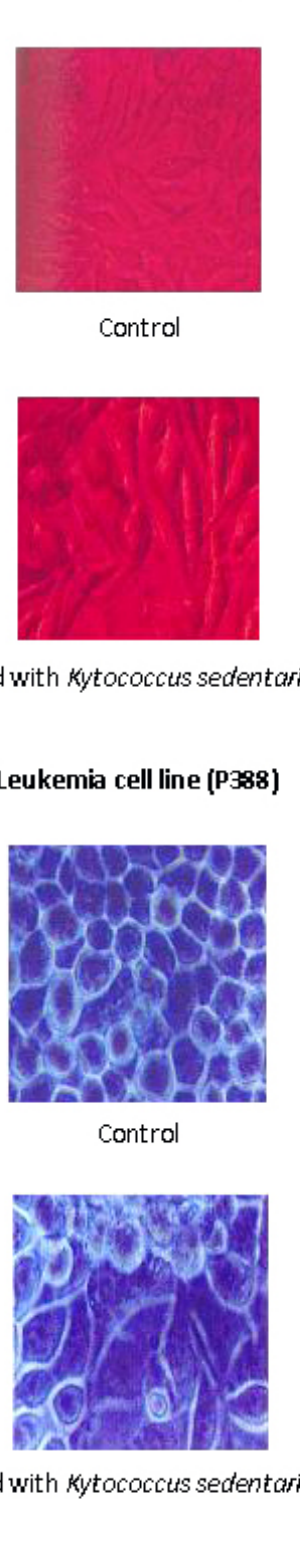
Figure 2. Growth inhibitory activity of Kytococcus sedentarius bacterial crude extract obtained from Arothron hispidus skin against two cell lines.